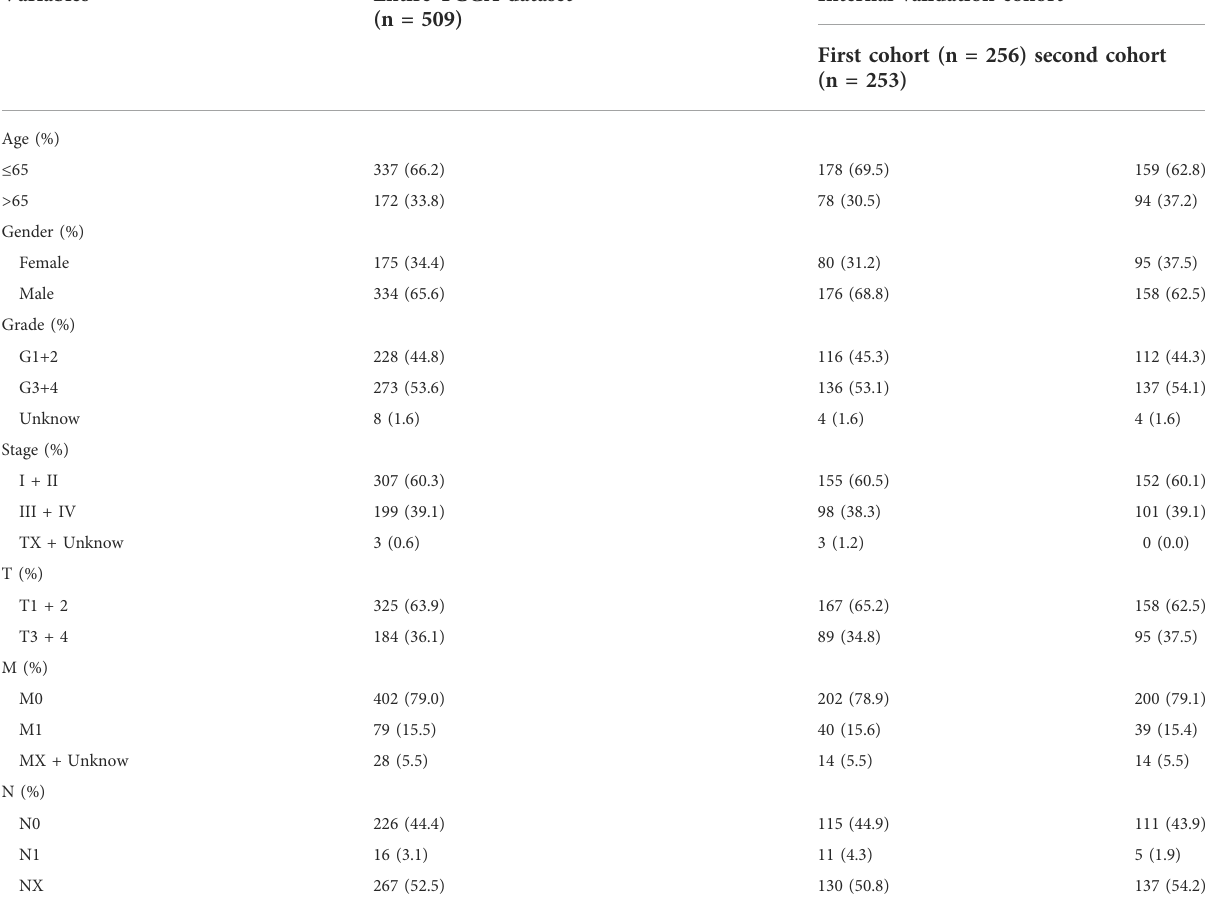
TABLE 1 The clinicopathologic features characteristics of patients in different